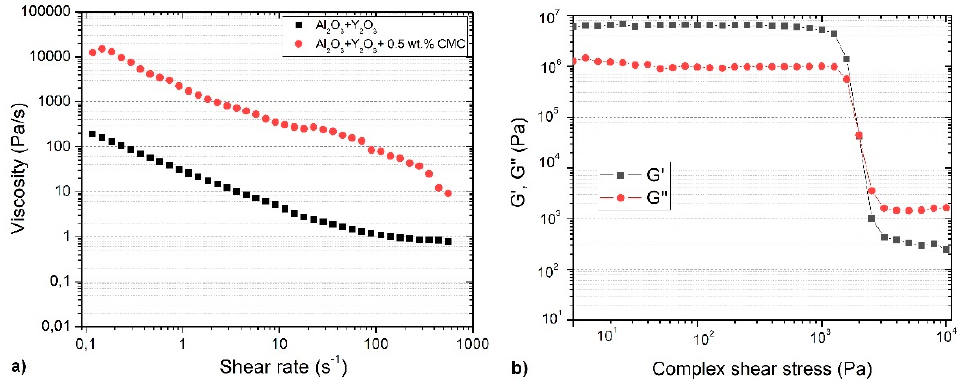
Figure 4. ( a ) Viscosity versus the shear rate of Al 2 O 3 –Y 2 O 3 suspensions containing 42 vol% of solids in the absence and presence of 0.5 wt% CMC; ( b ) amplitude sweep of final Al 2 O 3 –Y 2 O 3 ink containing 0.5 wt% CMC and 0.2 wt%